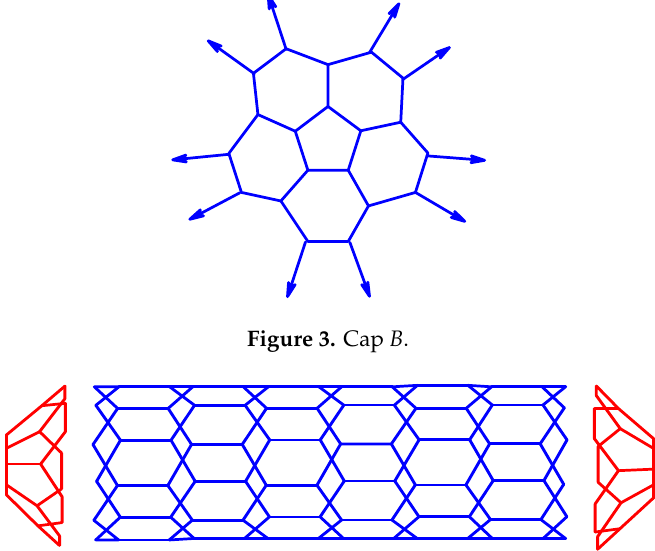
Figure 4. The presentation of fullerene A 10 n as a combining of two copies of B and the nanotube T Z [5, n − 4].